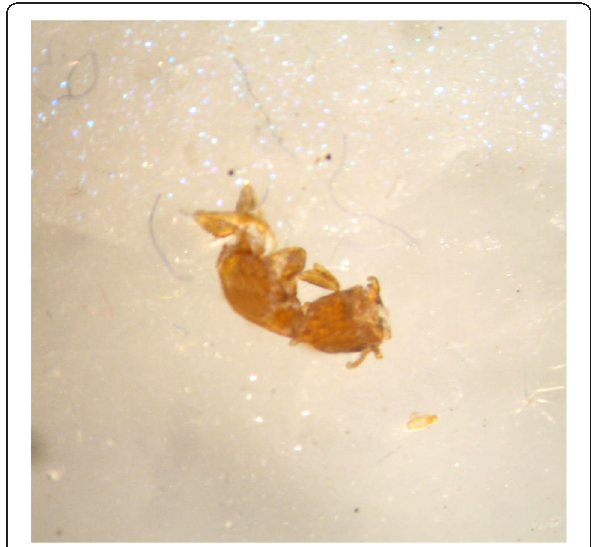
Figure 1 Dorsal view of the cephalothorax of Sclerodermus sp. by stereoscope. The head is visible while the antennae are only partially visible.